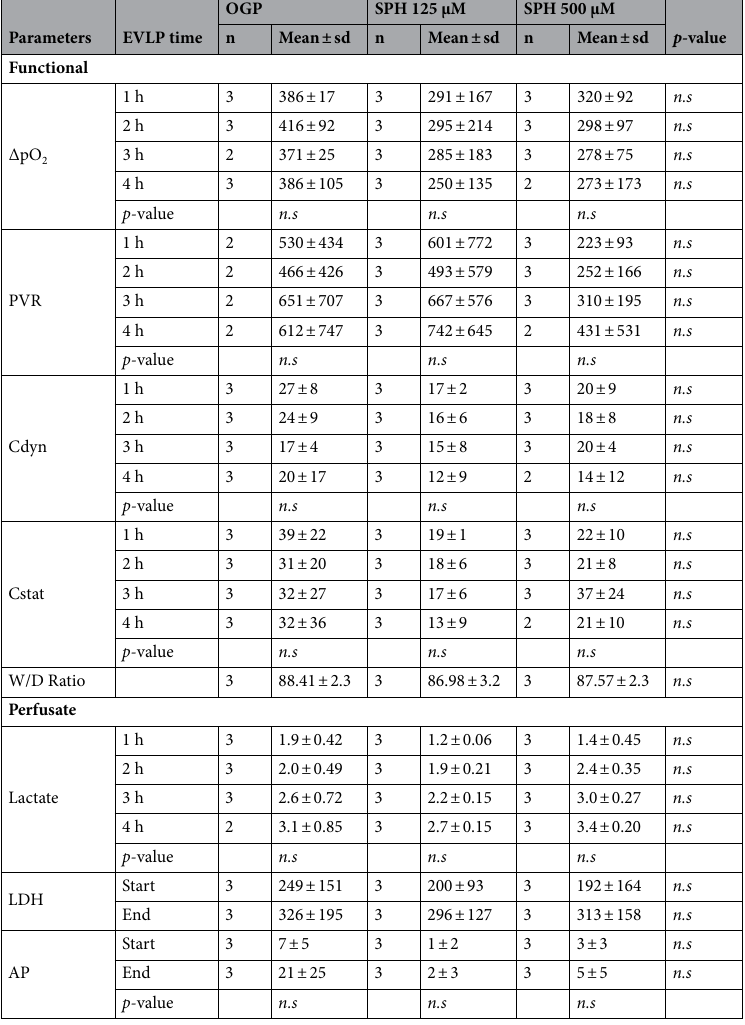
Table 1. Statistical analysis of the functional parameters ∆pO 2 (difference between pulmonary arterial to pulmonary venous oxygen partial pressure in the perfusate), Cstat and Cdyn (static and dynamic lung compliance), PVR (pulmonary vascular resistance), as well as the ratio between wet and dry weight after EVLP run (wet/dry ration, W/D-ratio) and perfusate measurements of lactate levels, activity of lactate dehydrogenase (LDH) and alkaline phosphatase (AP) after inhalation of a 125 µM (SPH 125), 500 µM (SPH 500) and 10% OGP (OGP) suspension in a 4 h EVLP run. Due to technical issues in terms of PGM failure with missing log- files, some functional parameters only have two evaluable samples. Given is the mean ± SD,